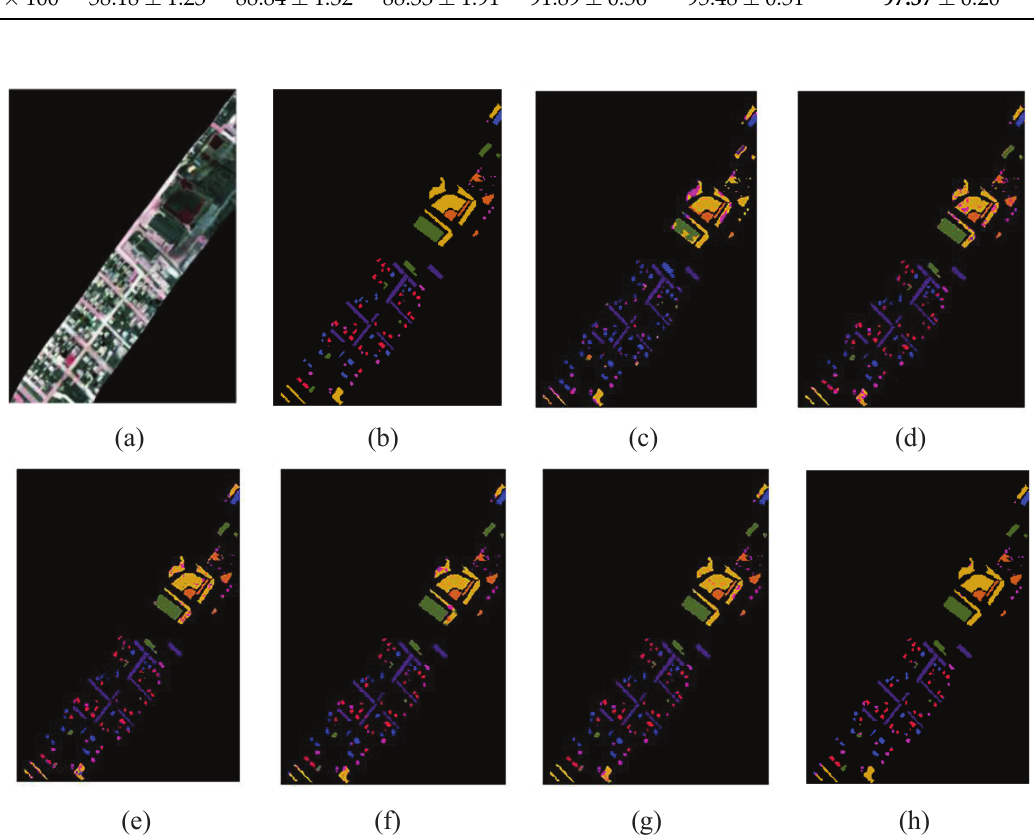
Figure 14. Classification maps provided for the Grss_dfc_2014 data set by different methods. ( a ) A false color map. ( b ) The ground truth map. ( c ) CNN (66.78%). ( d ) M3DCNN (90.45%). ( e ) SSRN (90.60%). ( f